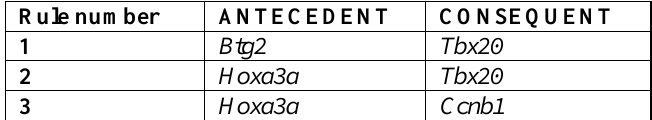
Table 1: An example extracted from the ZFIN result set using the PPM algorithm (support > 40% and confidence >